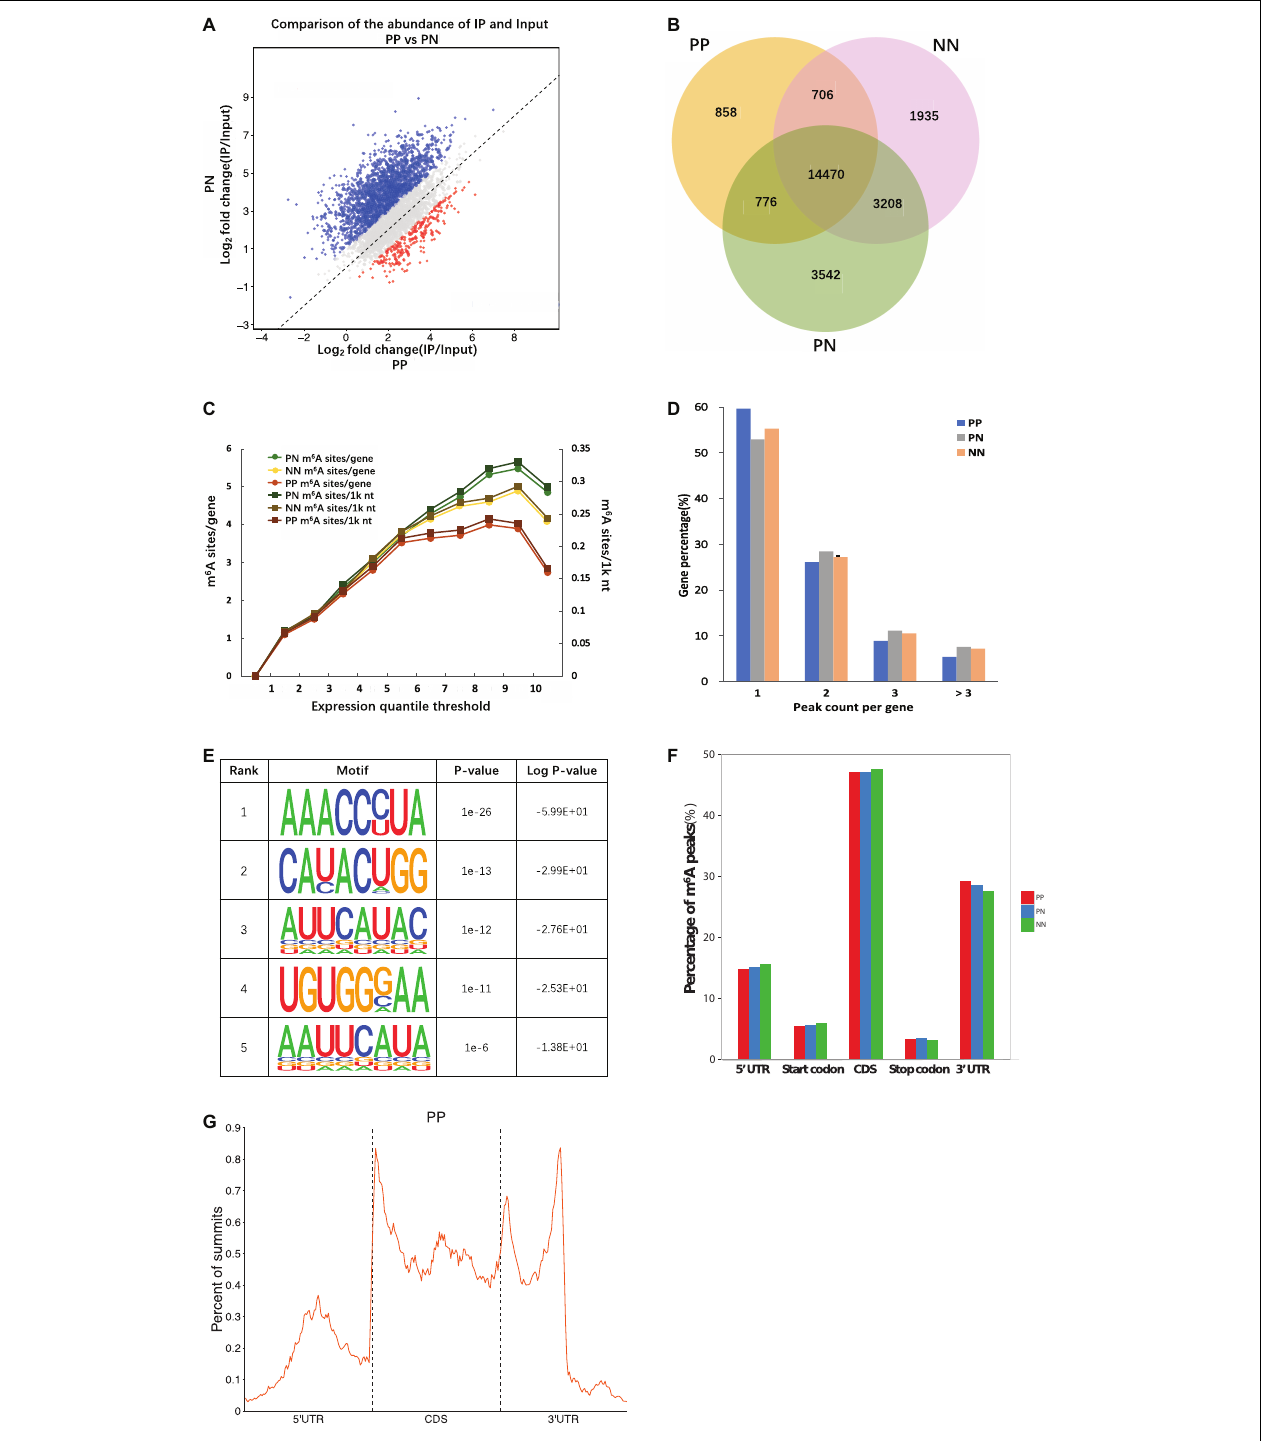
FIGURE 1 | Overview of m 6 A methylome in psoriatic vulgaris skin. (A) Comparison of the number of m 6 A peaks identified in PP and PN. (B) Numbers of group-specific and common m 6 A peaks. (C) Estimation of m 6 A density on transcripts. Transcripts with different expression level are divided to 10 groups, and the m 6 A density of PP, PN, and NN samples is calculated separately. ( D ) Percentage of m 6 A methylated genes with different m 6 A peak number. (E) The top five motifs enriched across m 6 A peaks identified from involved psoriatic skin samples. (F) Distribution of m 6 A peaks across the length of mRNAs. 5 (cid:48) UTRs, CDS, and 3 (cid:48) UTRs of PP mRNAs are individually binned into regions spanning 1% of their total length, and the percentage of m 6 A peaks that fall within each bin is determined. (G) The distribution of m 6 A peak from PP along a metagene.